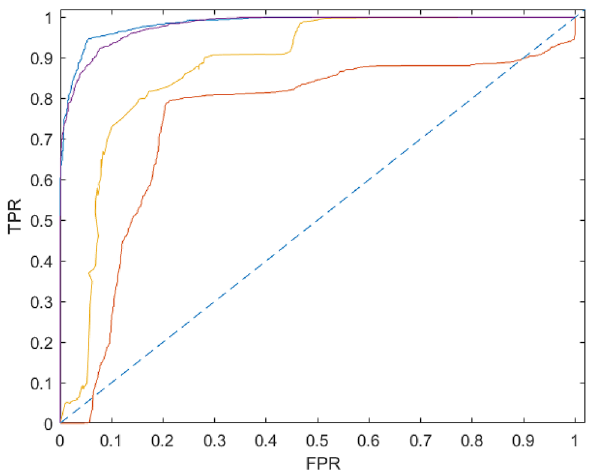
Figure 5. The receiver operating characteristic curves (AUC) for all the different models.